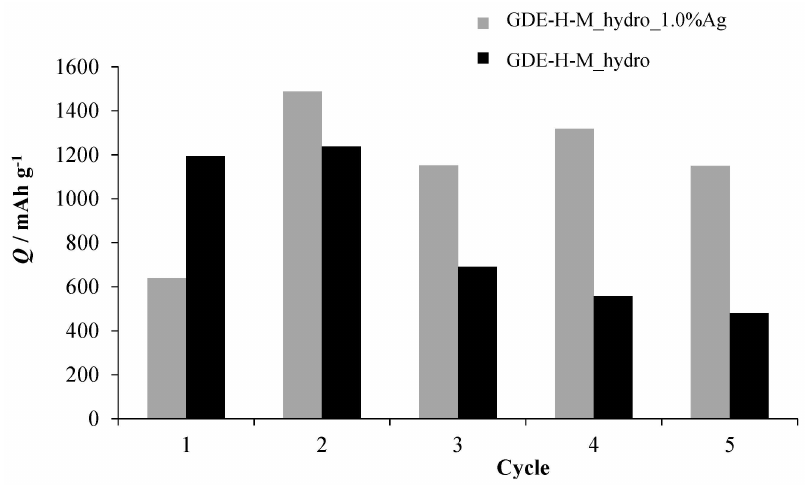
Figure 6. Specific capacity of GDE-H-M_hydro and GDE-H-M_hydro_1.0%Ag during the first five cycles in the home-made cell ( H -cell) (black and grey histograms,